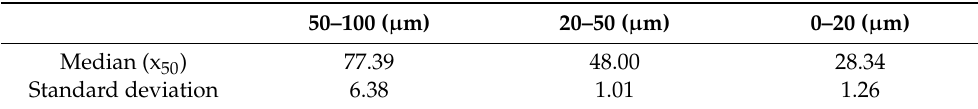
Table 3. Laser diffraction results of hydrogel particle size distribution of the grain size mass fractions <20 µ m, 20–50 µ m, and 50–100 µ m. Three averaged median values ( n = 3) for each size distribution are